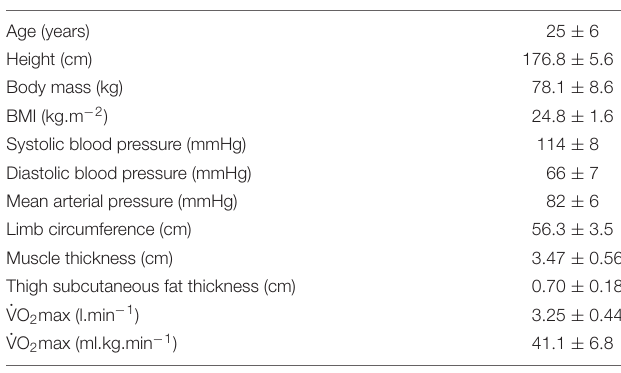
TABLE 1 | Participant characteristics.